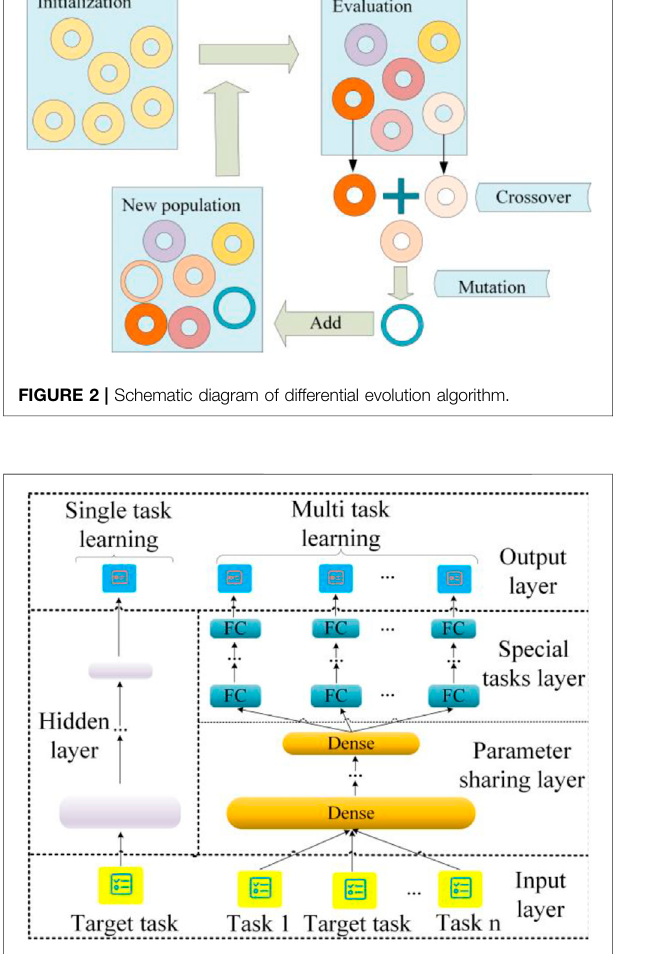
FIGURE 3 | Comparison between single-task and multi-task learning.